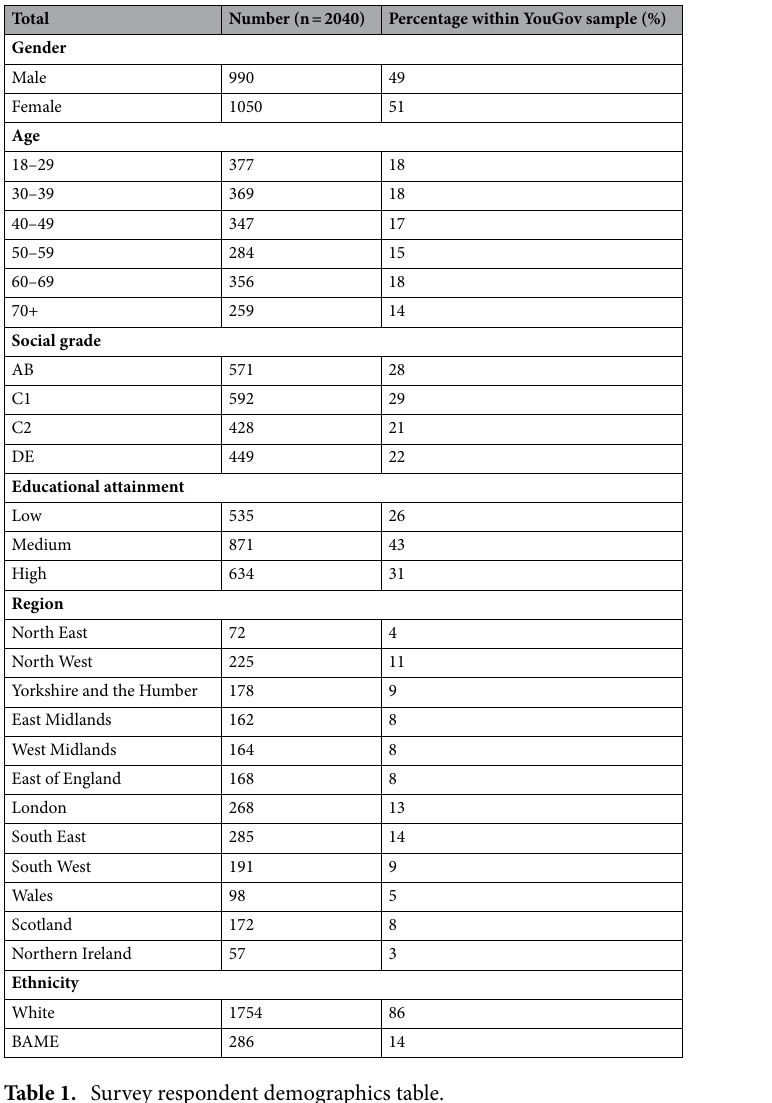
Table 1. Survey respondent demographics